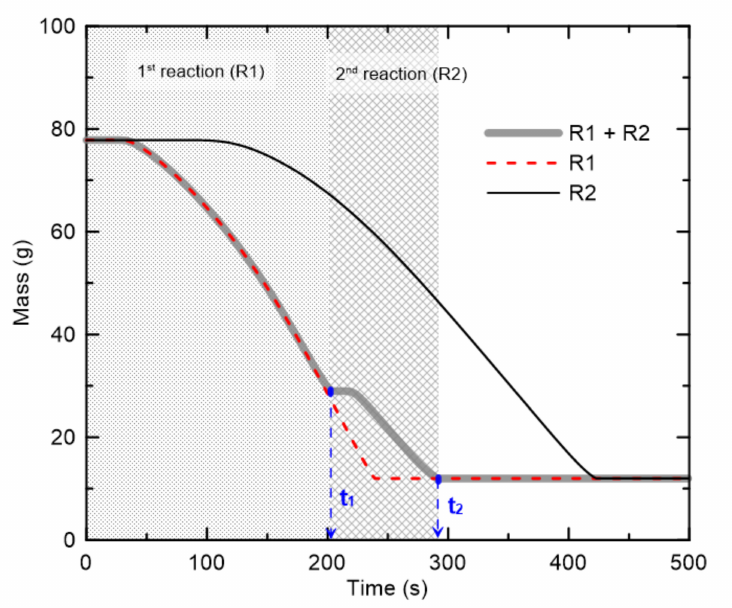
Figure 9. Predicted mass changes when two dominant pyrolysis reactions are considered separately and simultaneously.